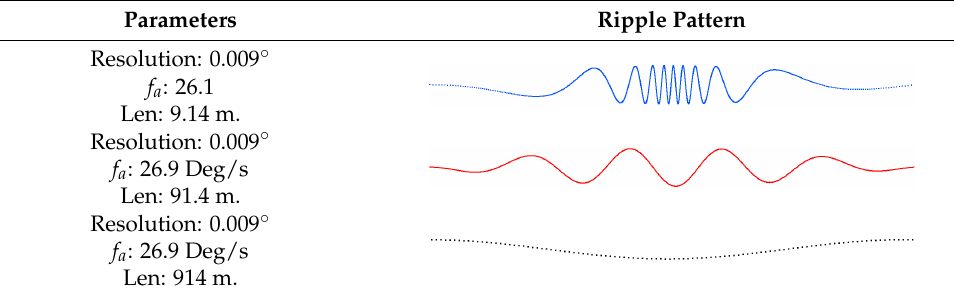
Table 7. Influence of the distance to the target on the ripple pattern. Parameters